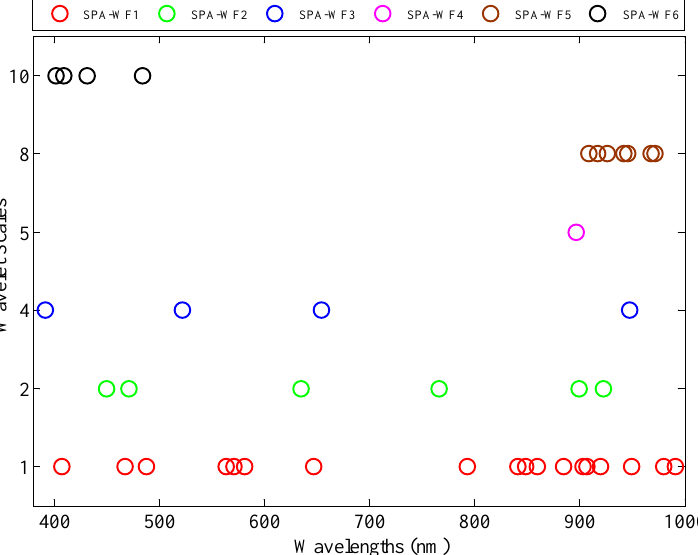
13 of 20 Table 4. The information of wavelet features selected using correlation analysis. Wavelet feature